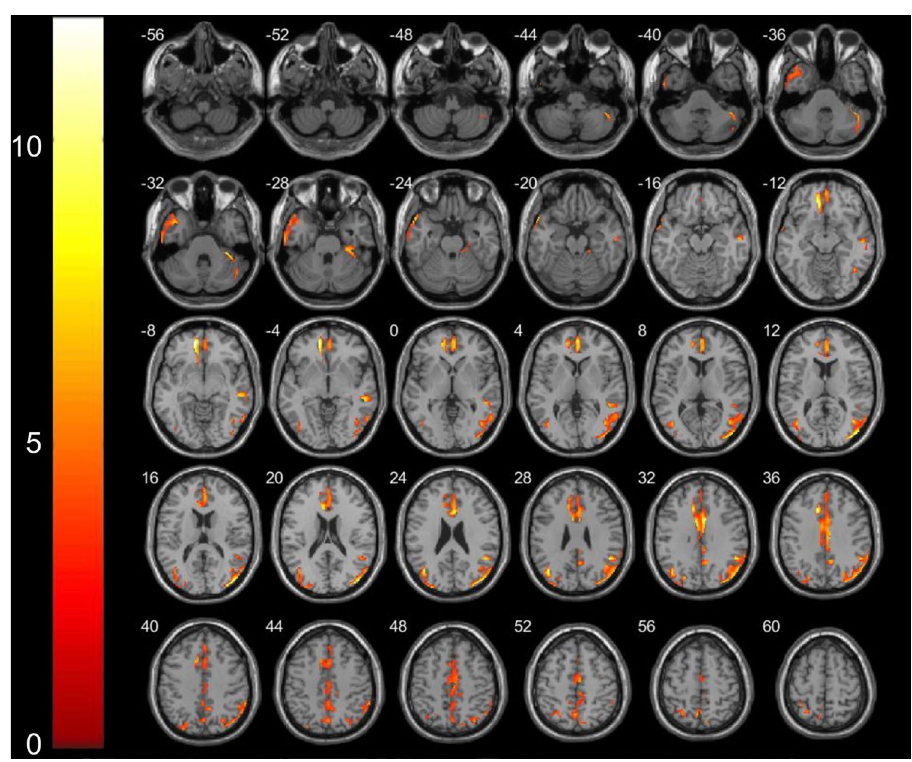
Figure 1. Areas showing decreased GM volume in axial slices (p < 0.001) in Meige syndrome patients and control subjects. In the left hemisphere in the middle frontal orbital gyrus (t = − 8.83, p < 0.001), temporal pole superior temporal gyrus (t = − 8.20, p < 0.001) and insula (t = − 7.98, p < 0.001); in the right hemisphere in the temporal pole middle temporal gyrus (t = − 7.32, p < 0.001), precuneus (t = − 5.99, p < 0.001), inferior parietal (t = − 5.84, p < 0.001), inferior temporal (t = − 5.03, p < 0.001)and olfactory cortices (t = − 4.95, p < 0.001).